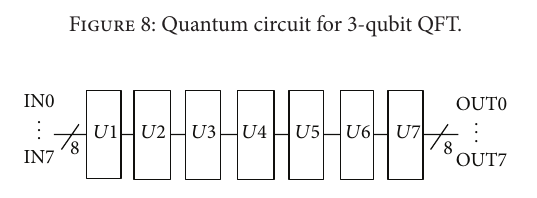
Figure 9: The 3-qubit QFT in terms of a sequence of unitary